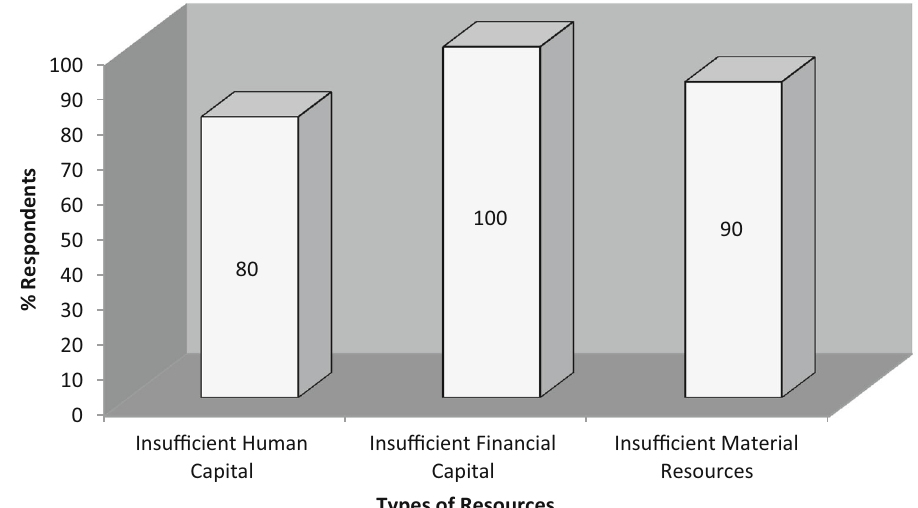
Fig. 5 Percentage of